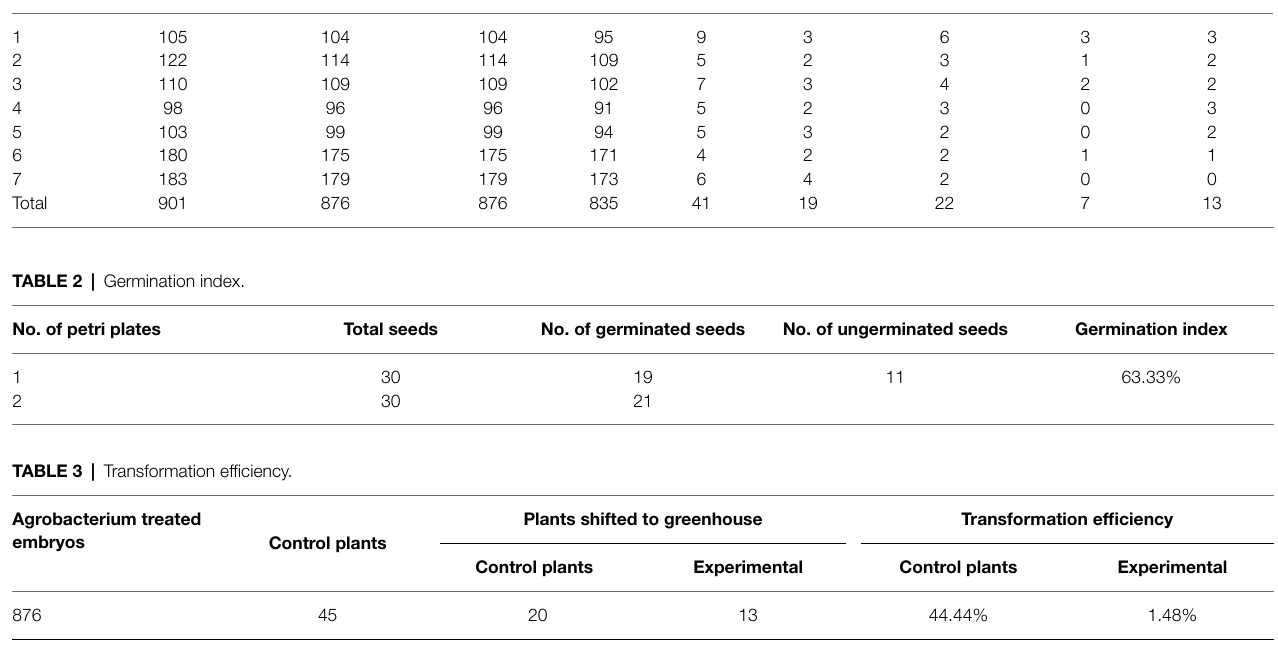
TABLE 1 | Numerical data for transformation experiments. Exp. No.